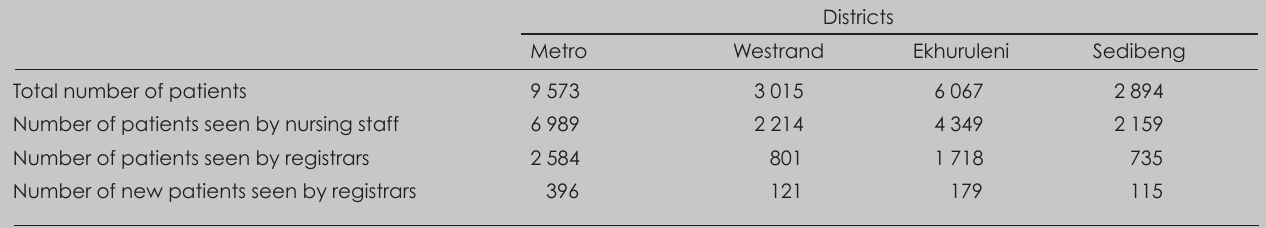
Table III. Mean monthly attendance figures in the districts for 2005